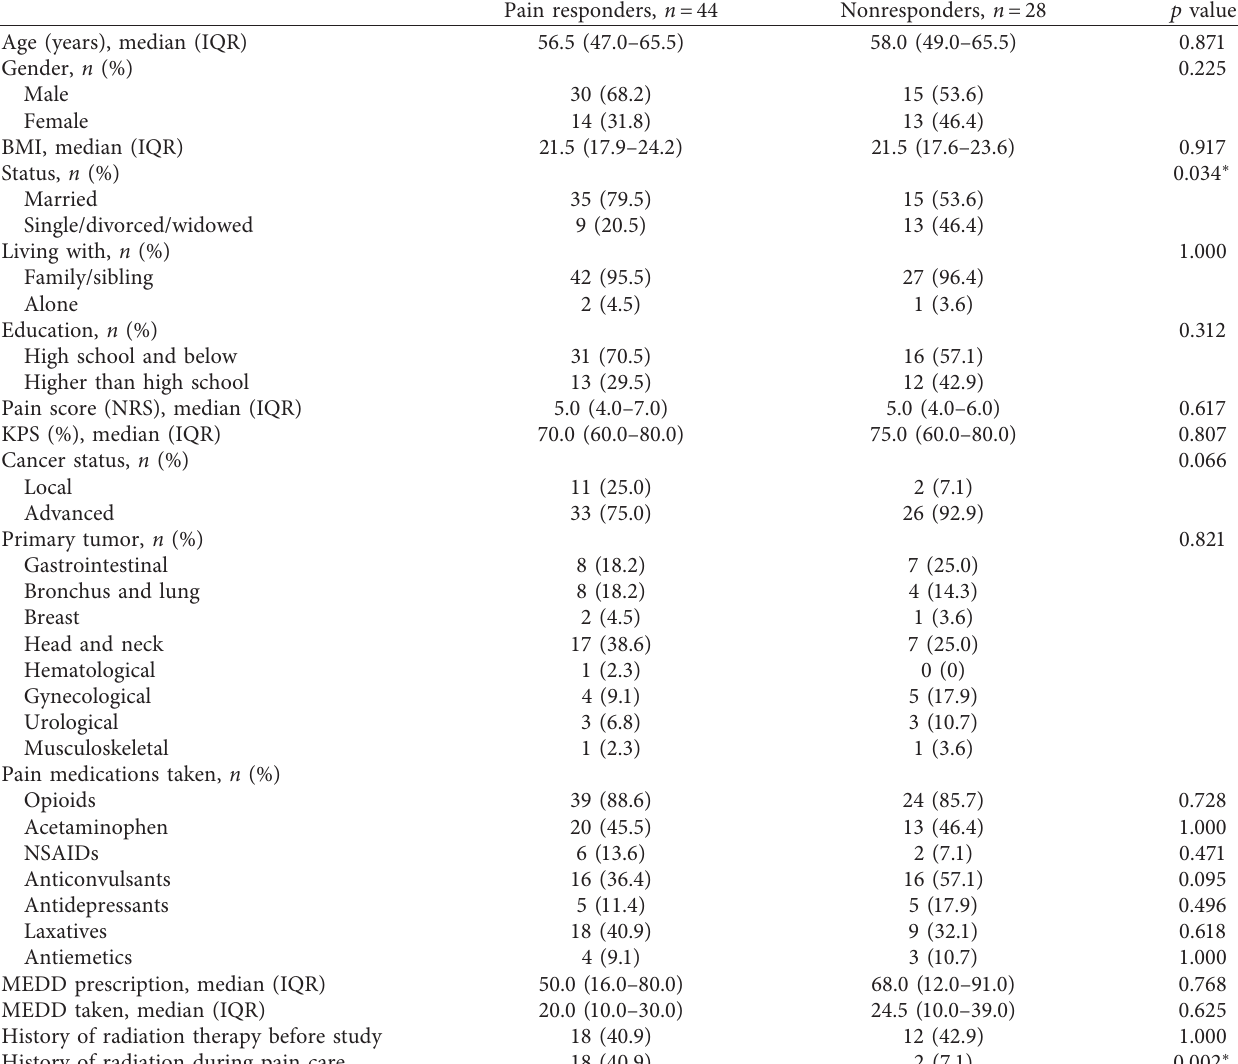
Table 2: Demographic data difference between pain responders and nonresponders at FU3.